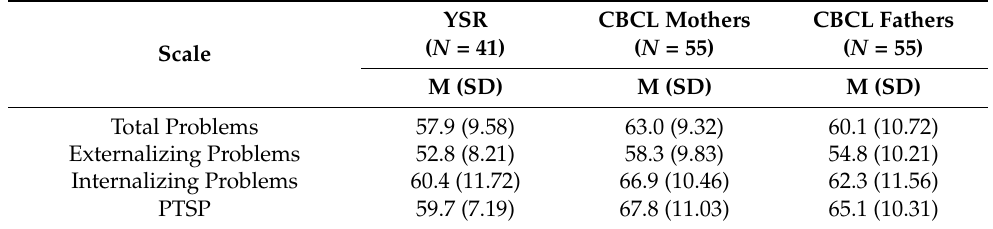
Table 1. Mean (M) and Standard Deviation (SD) values in the main YSR and CBCL scales of patients at T0.